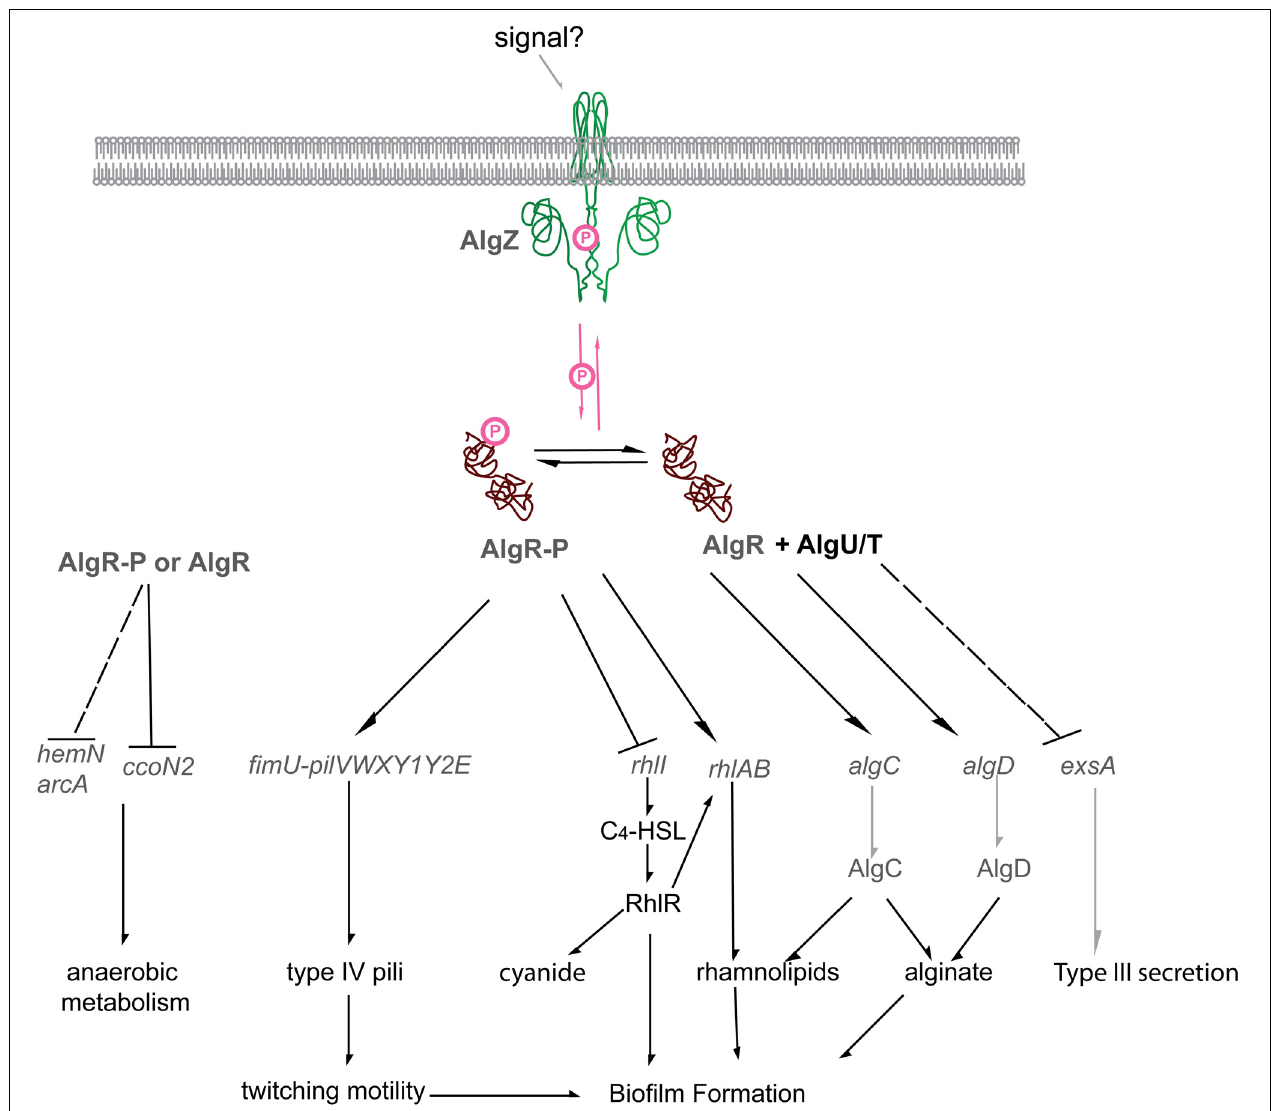
FIGURE 5 | The P. aeruginosa AlgR regulon . Diagrammatic representation of the current AlgR regulon. Phosphorylated AlgR activates expression of the pseudopilin operon fimU pilVWXY1Y2, as well as modulates the expression of rhlA, but represses rhlI . Unphosphorylated AlgR activates expression of alginate biosynthetic genes algD and algC but represses the